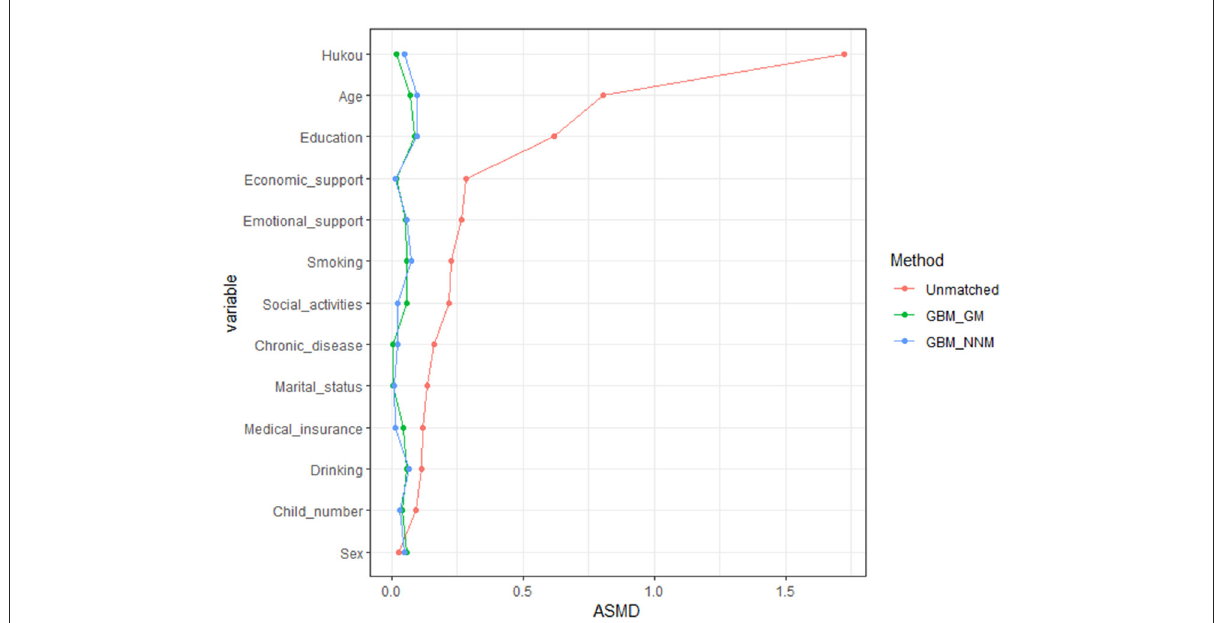
FIGURE1 Comparison of the ASMD of the covariates before and after GBM_GM and GBM_NNM (ASMD, average standardized absolute mean difference; GBM_GM, genetic matching based on the generalized boosted model; GBM_NNM, nearest neighbor matching based on the generalized boosted